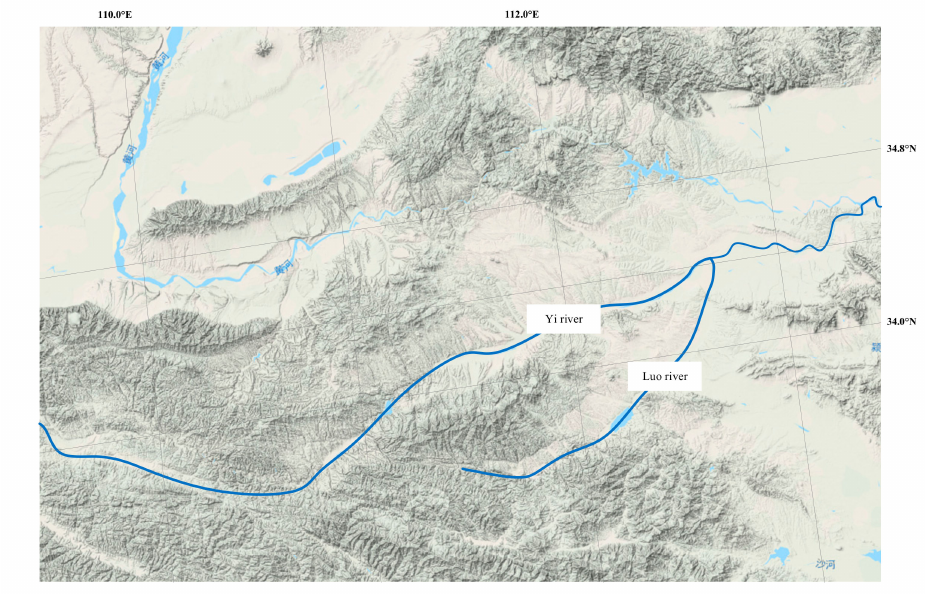
Figure 2. Location of Yiluo river